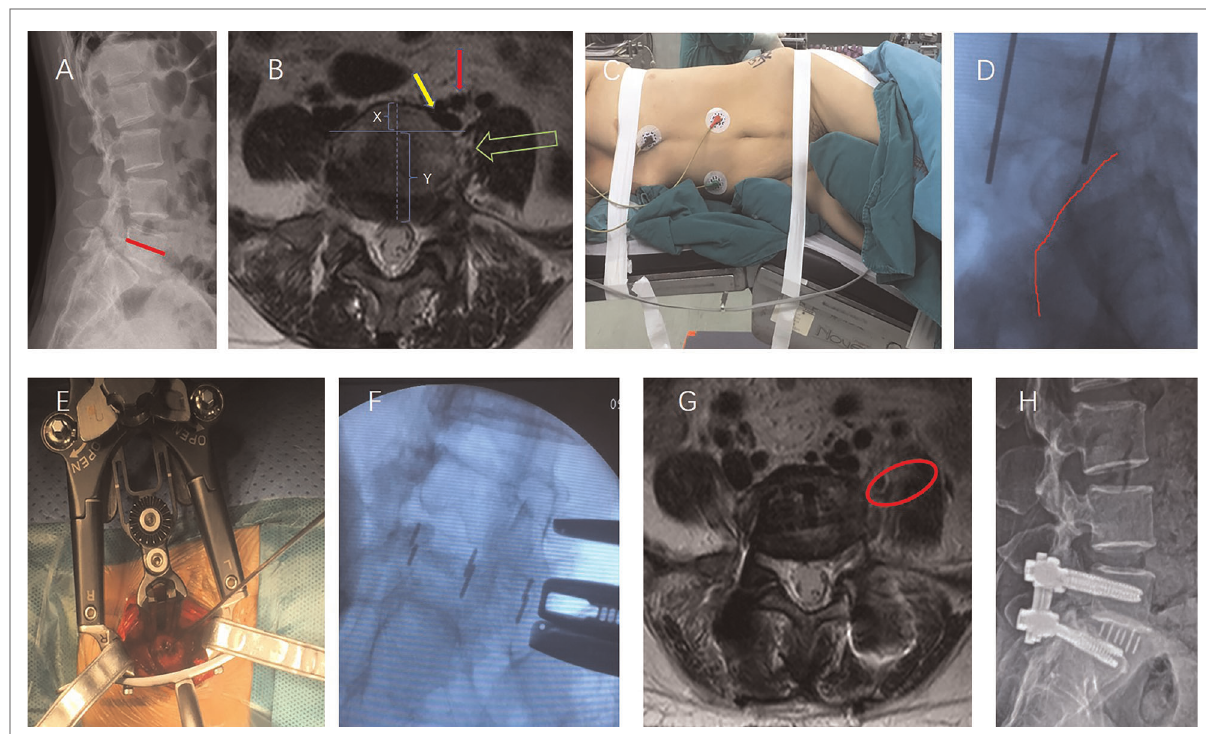
FIGURE 1 A 47-year-old woman underwent XLIF at the L5/S1 level. ( A ) Preoperative radiograph showed L5 degenerative spondylolytic spondylolisthesis, and the iliac crest was below the 1/2 line of the L5 vertebra (the red line). ( B ) The picture shows that the XLIF approach at L5-S1 in this case (green arrow) was feasible without obstruction of the left common iliac vein (yellow arrow) and the left iliac artery (red arrow). The iliac vessels were located in the fi rst quarter of the intervertebral space (X:Y<1:3). ( C ) Surgical position. ( D ) The iliac crest (red line) is lowered below the L5/S1 intervertebral space. ( E ) Intraoperative photograph showing the L5 – S1 disk was exposed. ( F ) Intraoperative fl uoroscopy after the implantation of the cage. ( G ) The red circle shows the working channel through the left psoas at L5/S1. ( H ) Radiographs taken 3 months postoperatively showed slip reduction with good cage